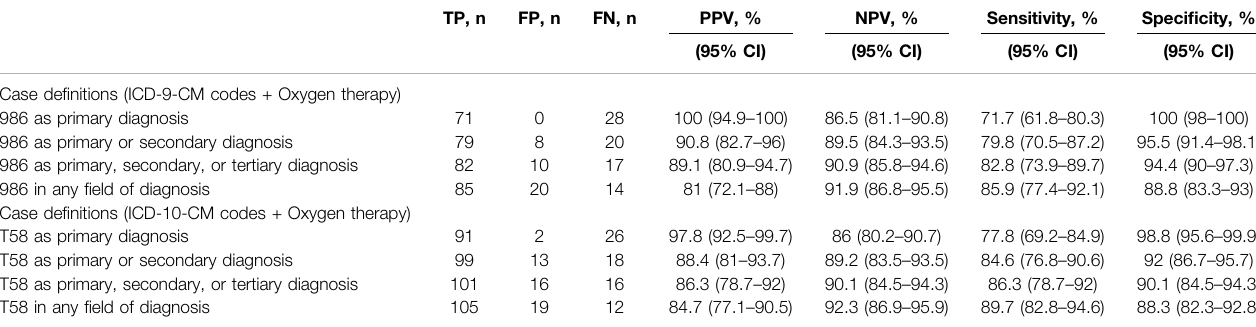
TABLE 3 | Accuracy of combined case de fi nitions plus oxygen therapy to identify carbon monoxide poisoning cases.